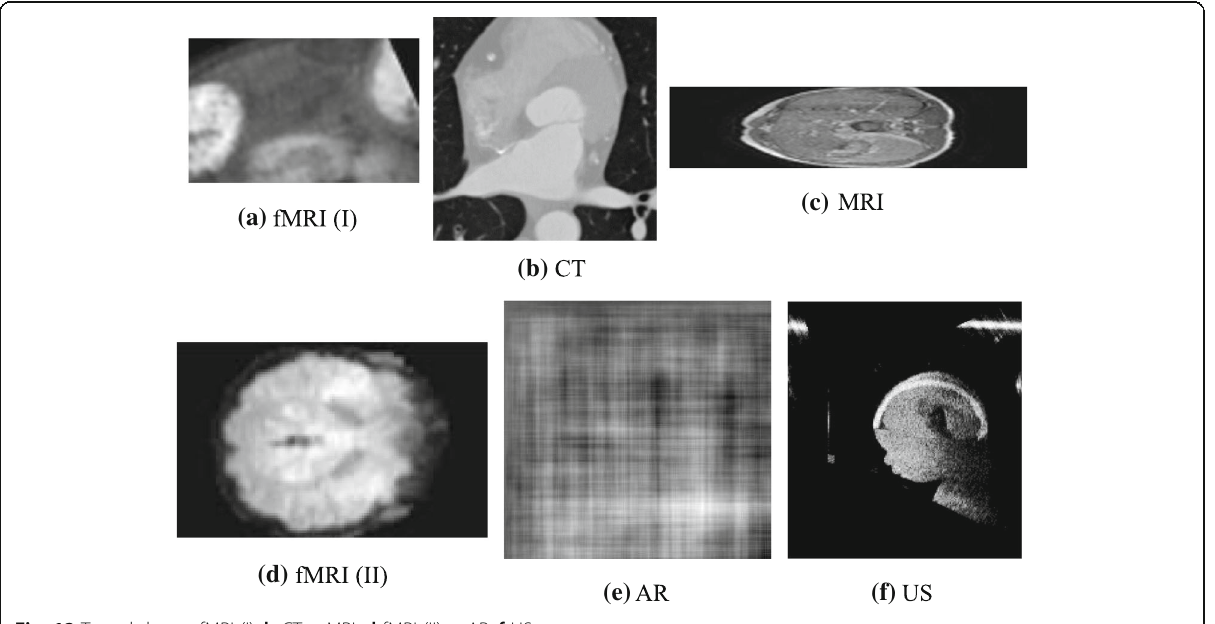
Fig. 12 Tested data. a fMRI (I). b CT. c MRI. d fMRI (II). e AR. f